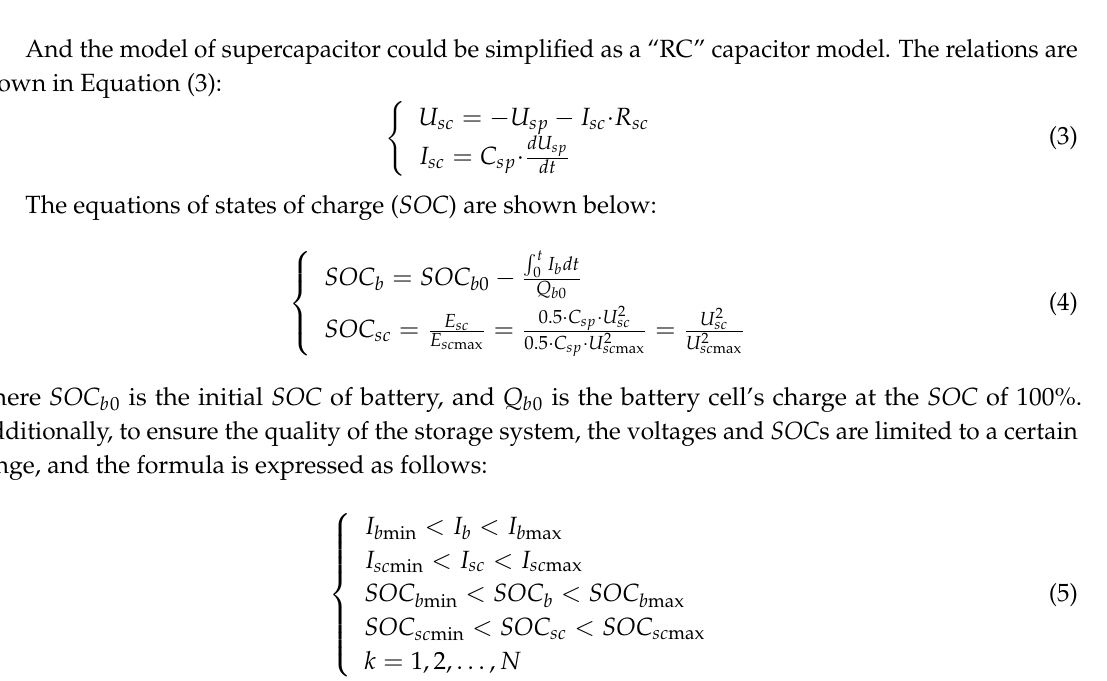
Figure 4. Models of battery and supercapacitor. ( a ) Battery model. ( b ) Supercapacitor